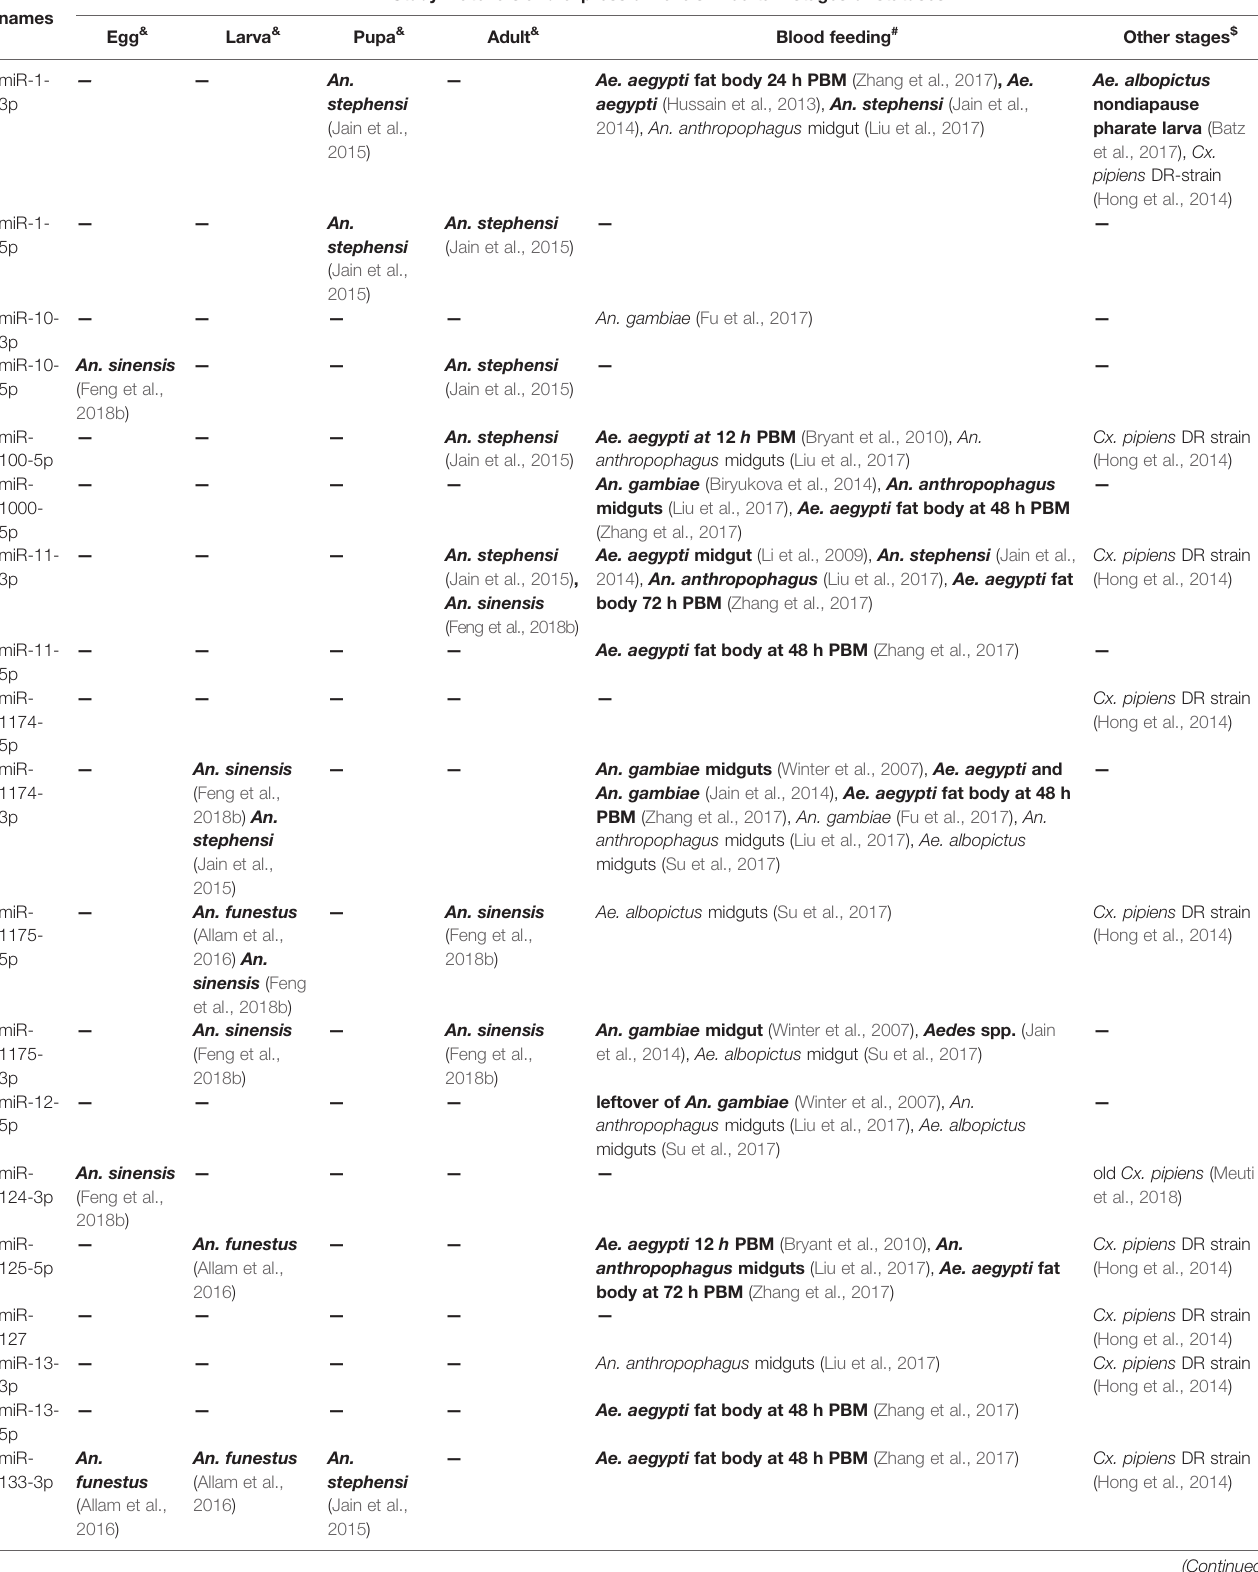
TABLE 4 | Stage- or status-speci fi c